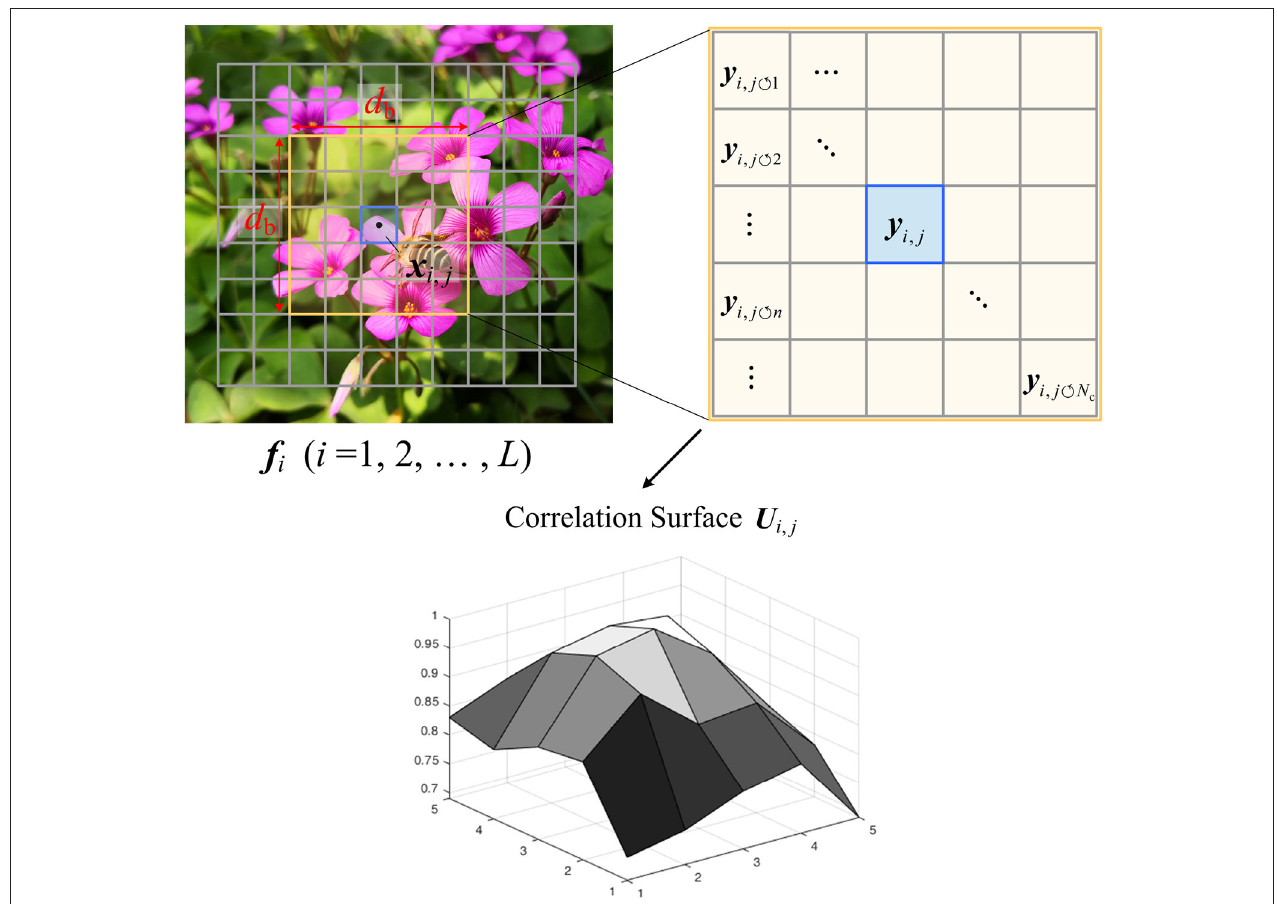
FIGURE 4 | Illustration on contexts extraction based on Compressive Sensing (CS)